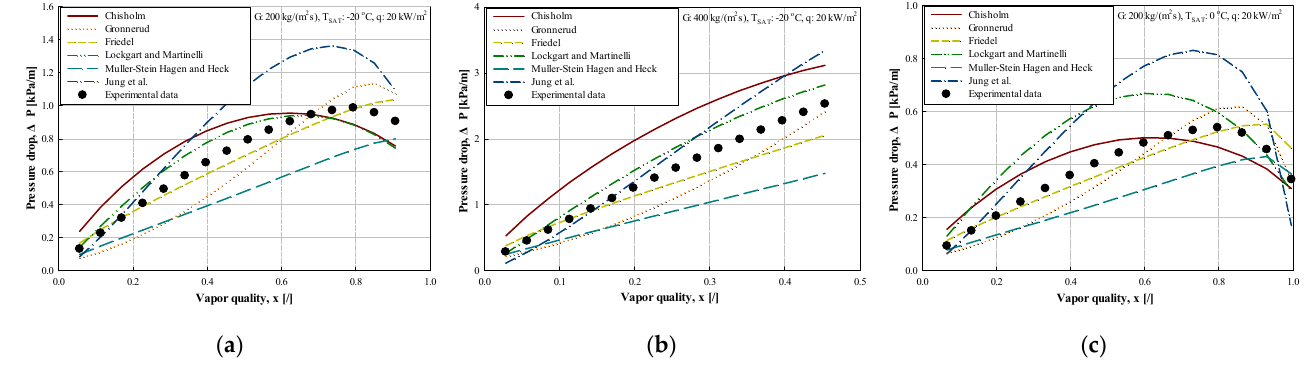
Figure 15. Comparison of the pressure drop calculated using existing correlation and experimental pressure drop according to the increase of vapor quality under each given condition ( a – c ). with an absolute mean deviation rate of 8.89%, and the correlation formula of deviation rate of 32.96%. In Figure 15b, the correlation formula of Friedel [54] shows good agreement with an absolute mean deviation rate of 14.31%, and the correlation rate of 52.49%. And, in Figure 15c, the correlation formula of Friedel [54] yields the best prediction with an absolute mean deviation rate of 11.65%, and the correlation formula of Jung et al. [52] has the highest deviation rate with an absolute mean deviation rate of 44.19%.